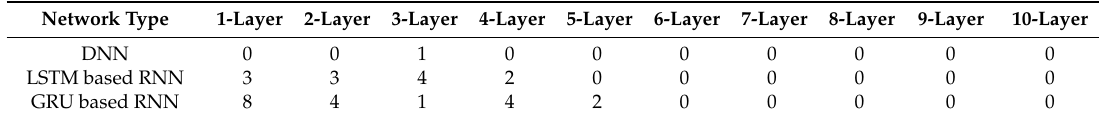
Table 2. Number of layers of the survival